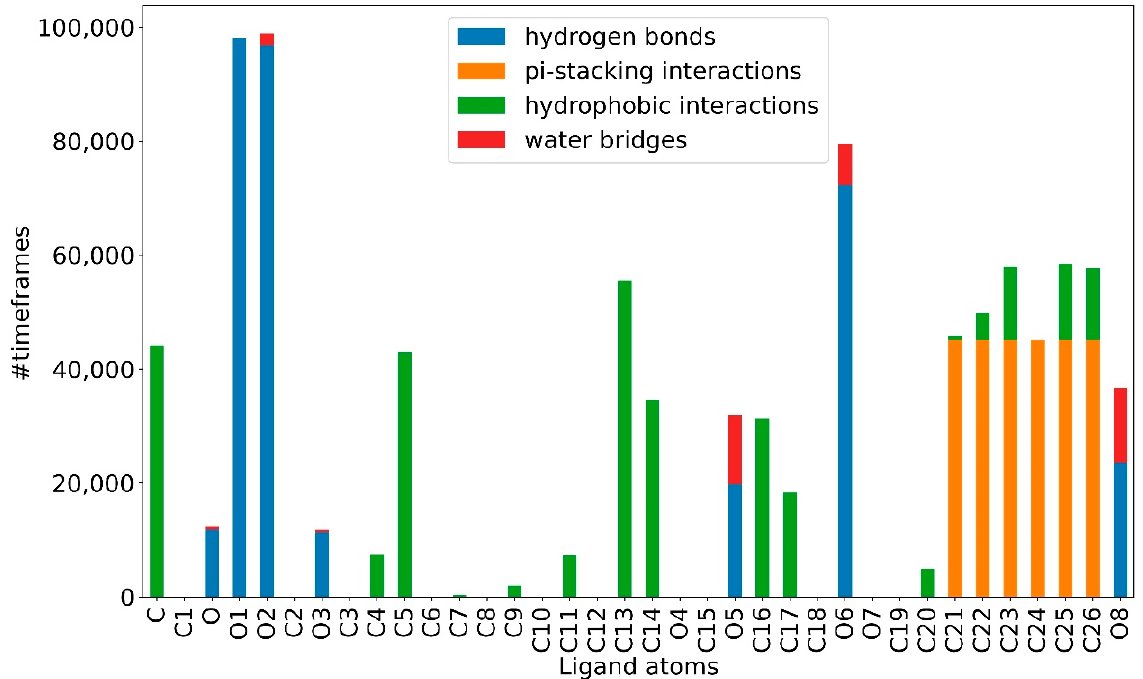
Figure 8. Type of bond established by a single atom of the c6 ligand.